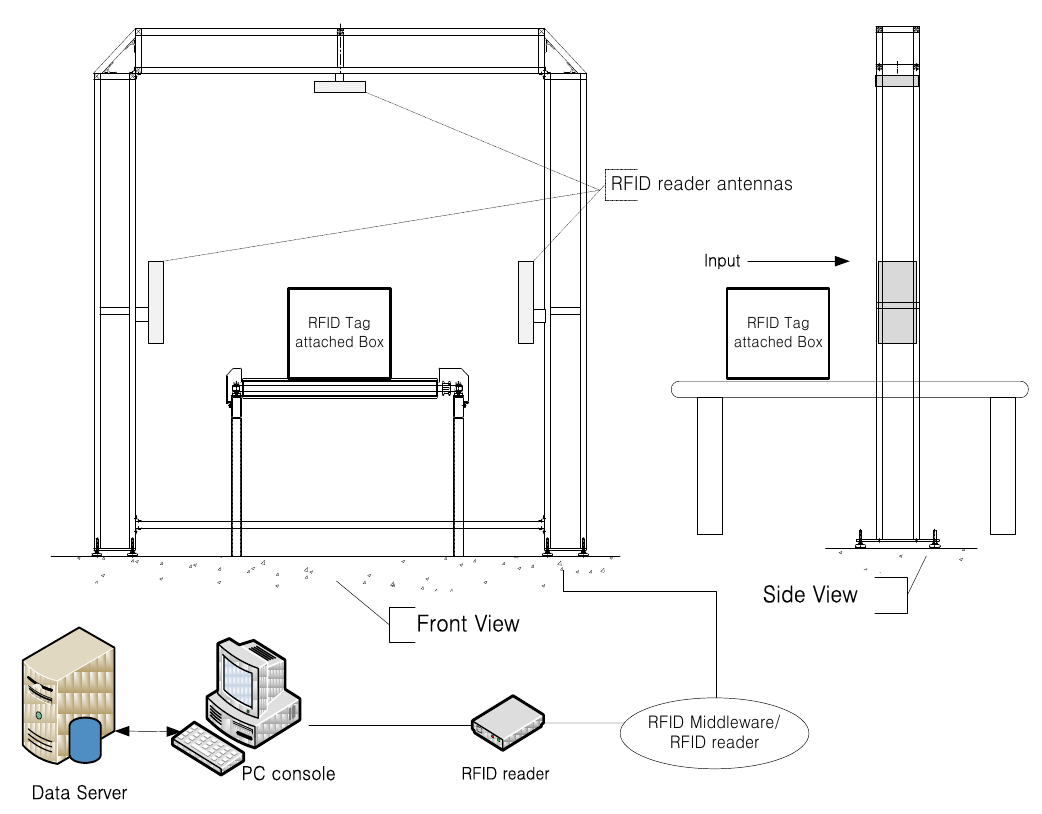
Figure 2. Standard structure ofRFID conveyor belt